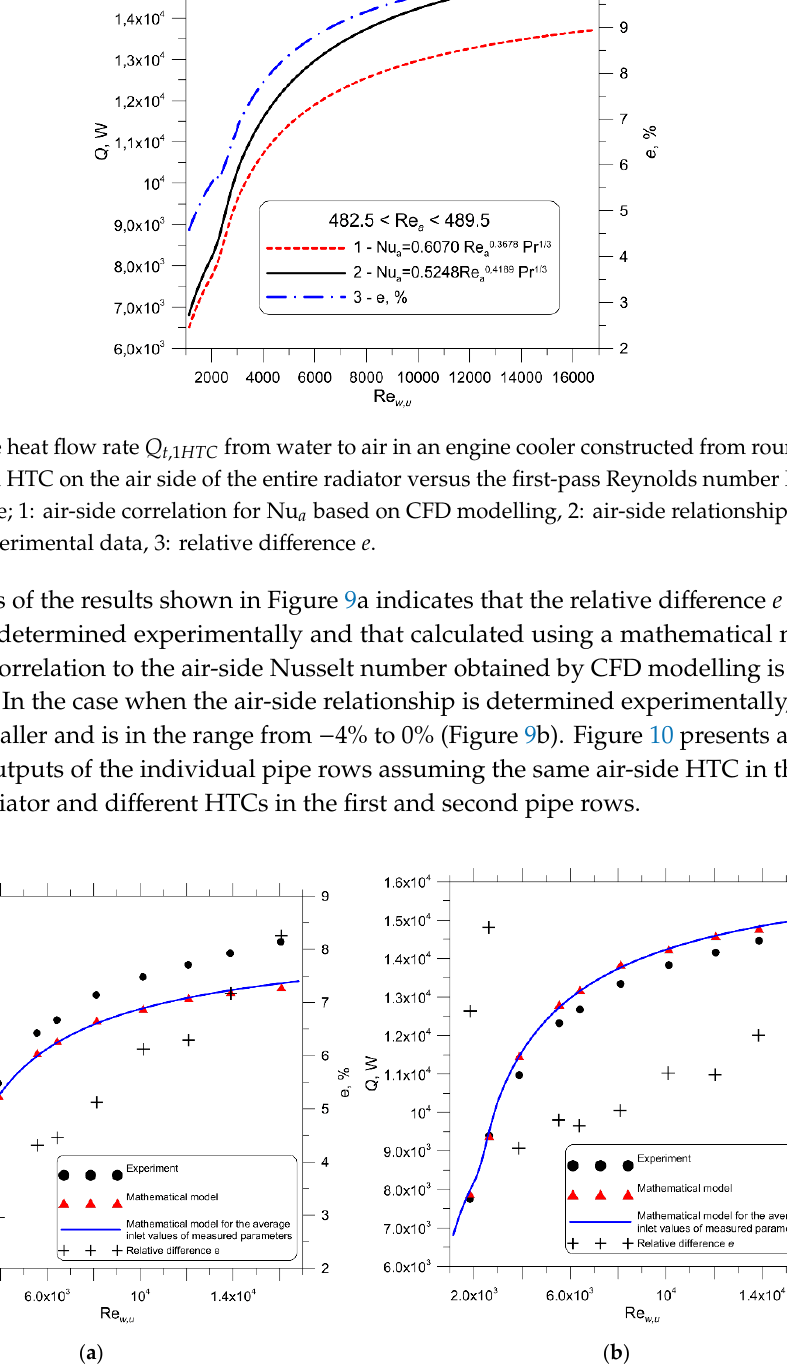
Figure 9. The comparison of radiator output Q versus the water-side Reynolds number Re w , u obtained experimentally and using the mathematical model of the engine cooler with the uniform air-side Nusselt number Nu a determined by ( a ) CFD modelling and ( b ) empirical correlation; e : relative difference.